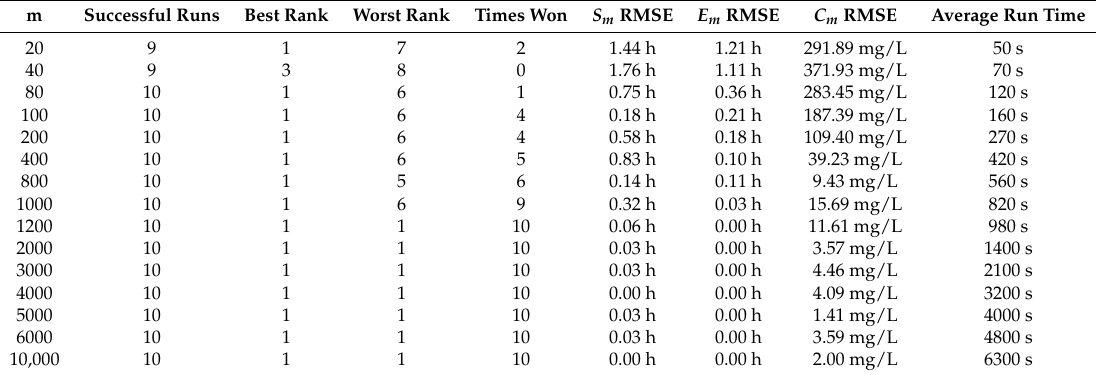
Table 7. Influence of the number of MC simulations on the accuracy and efficiency of the algorithm.